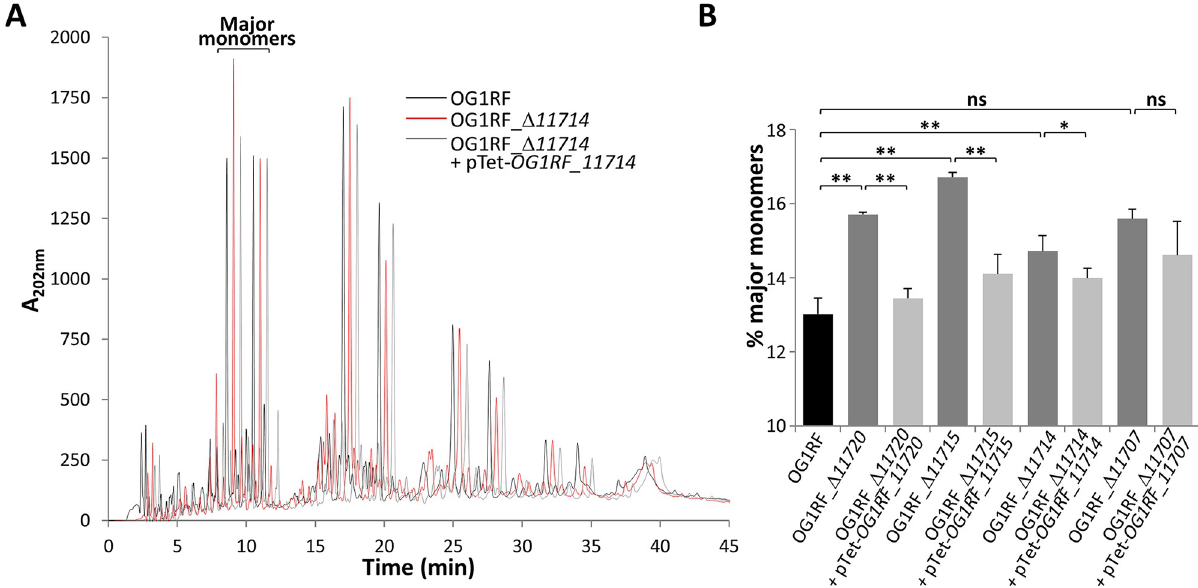
Fig 6. Peptidoglycan structural analysis of epa muants. Peptidoglycan was extracted from three biological replicates, digested with mutanolysin, reduced, and disaccharide-peptides were separated by reverse-phase HPLC. The traces shown represent averaged values from the three independent analyses A . A representative set of HPLC traces corresponding to the wild type OG1RF, mutant Δ 11714 and complemented mutant is shown. For the sake of comparison, the UV values were normalised, using the intensity of the most abundant monomer as a reference. B . Statistical significance determined by unpaired t -test with Welch’s correction comparing the relative abundance of major monomers in peptidoglycan samples; ns, P > 0.05; � P < 0.05; �� P < 0.01.